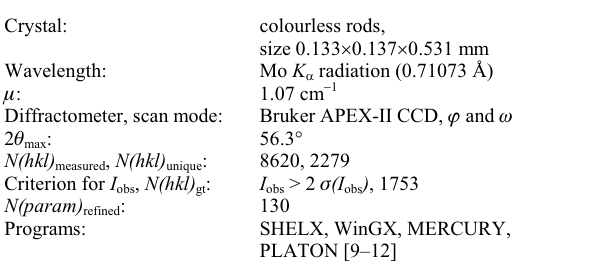
Table 1. Data collection and